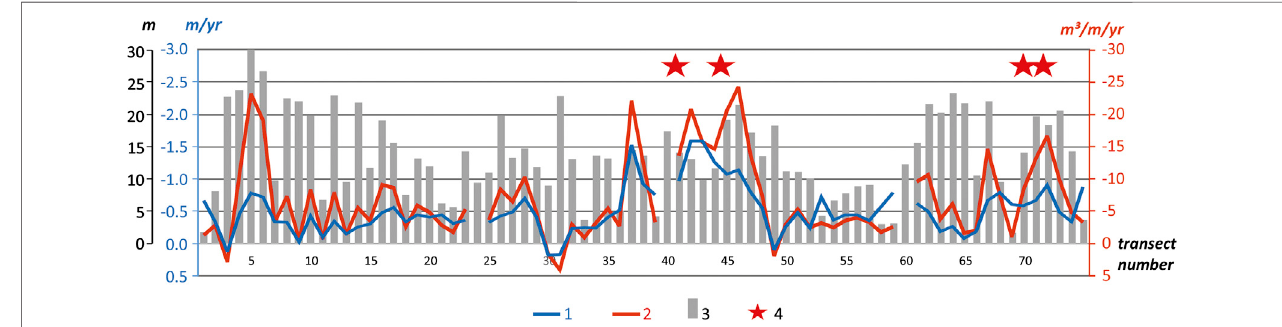
FIGURE 7 | Distribution of erosion rates in 1964 – 2019, cliff heights and position of outcrops of massive ice beds (summer 2016) along the shoreline. The y axes show (from left to right): bluff height, planimetric coastal erosion rates, volumetric coastal erosion rates; the x axis shows the number of transects from the south to the north. 1 — linear erosion rates, 2 — volumetric erosion rates, 3 — cliff height, 4 — outcrops of massive ice beds exposed in July 2016.